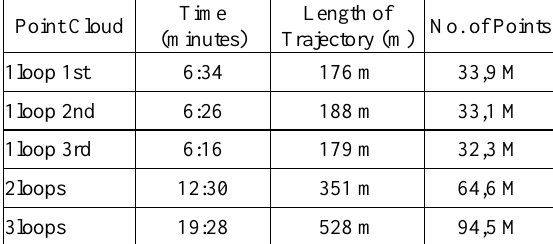
Table 1: General information about captured point